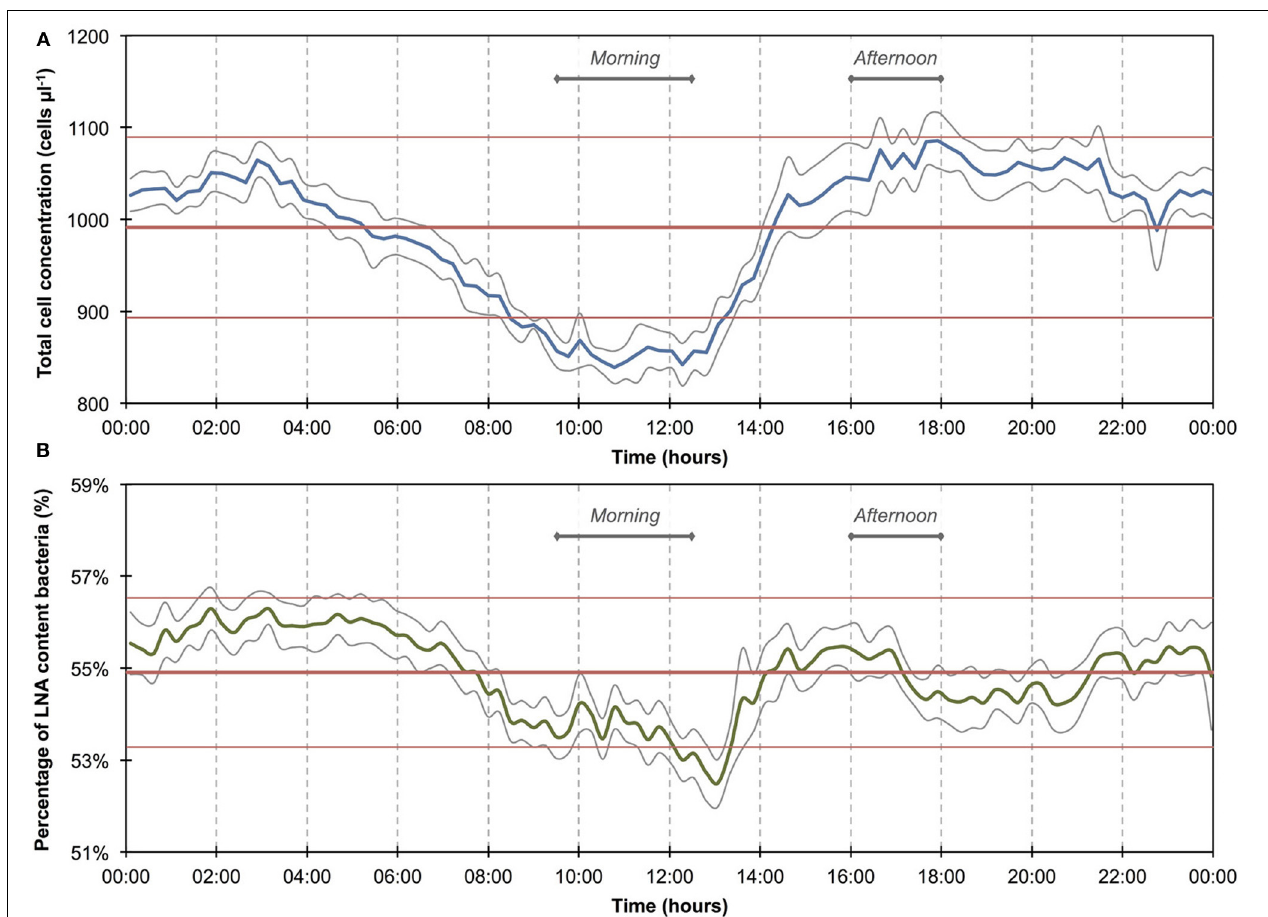
FIGURE 4 | Baseline data of daily microbiological fluctuations in river water for total cell concentrations (A) and percentage LNA content bacteria (B). The data set ( n = 740) comprises only data outside of the two apparent events ( Figure 3 ). Blue and green lines are 15-min averages of all